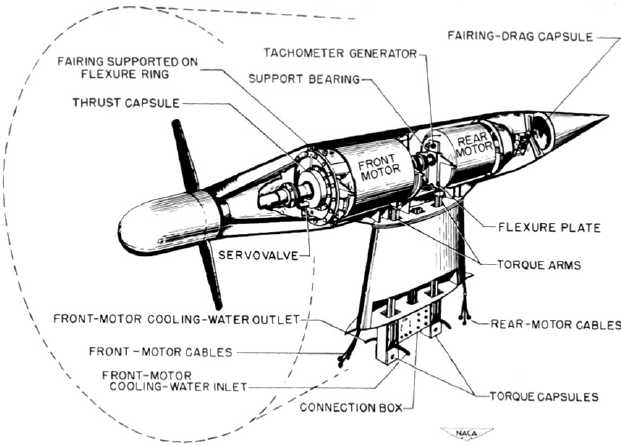
Figure 2. NASA Langley 2000 hp dynamometer schematic [20].